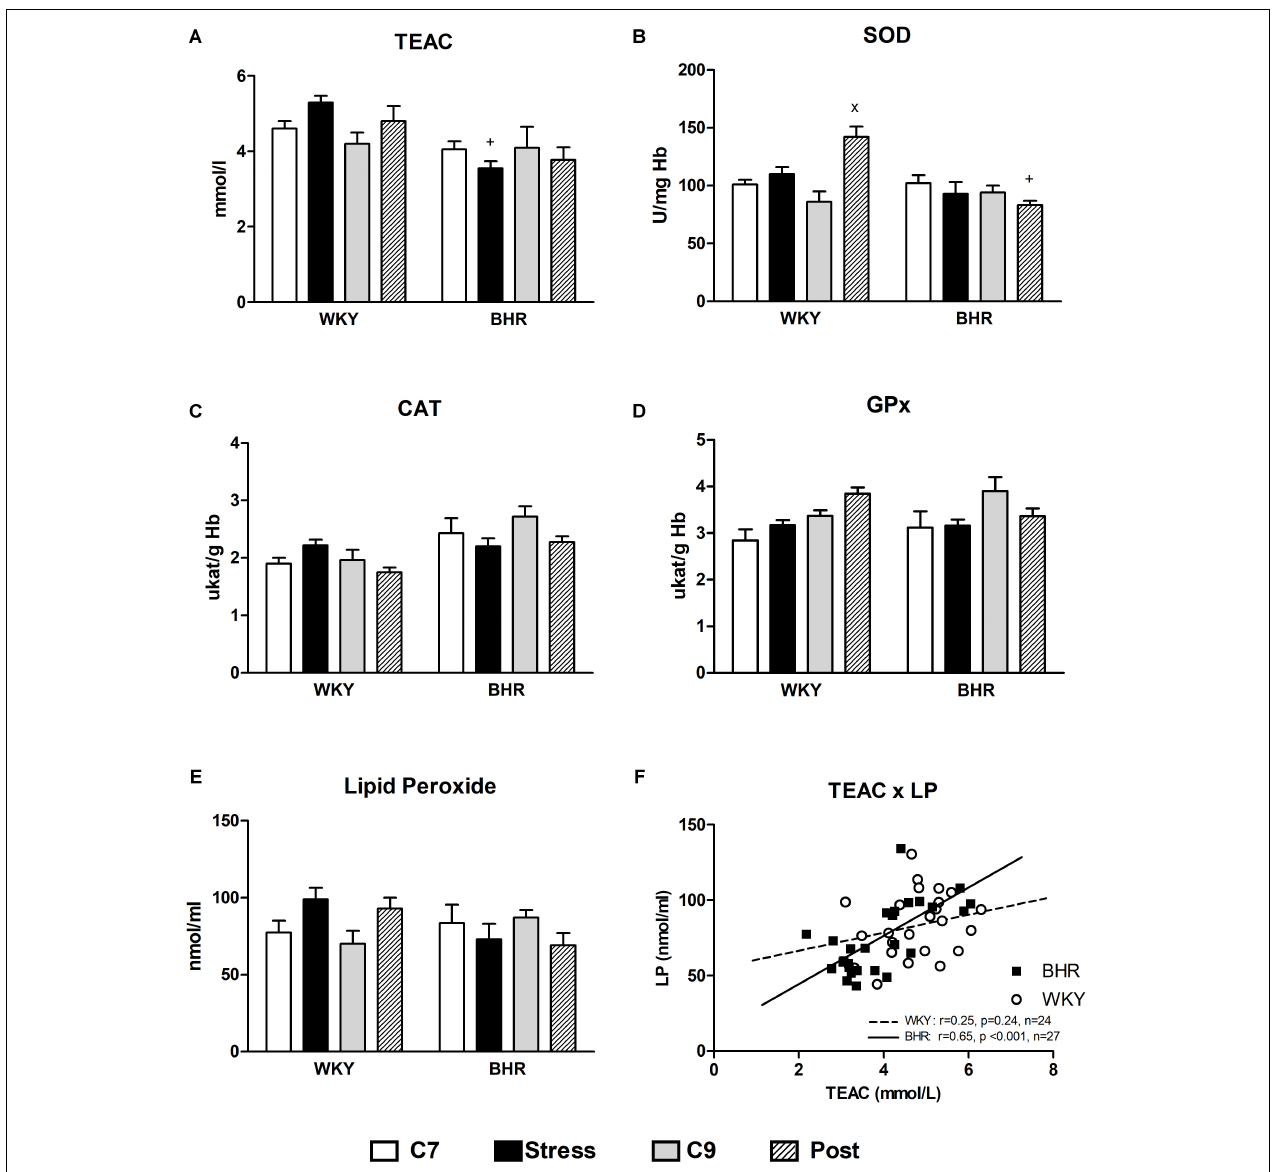
FIGURE 3 | Parameters of oxidative status (A–E) in the blood of normotensive Wistar-Kyoto (WKY) and borderline hypertensive (BHR) rats in 7-week controls (C7, white bar), stress (black bar), 9-week controls (C9, gray bar) and post-stress (Post, strip bar). (F) Shows correlations between TEAC and LP in WKY and BHR rats. CAT, catalase; GPx, glutathione peroxidase; Hb, hemoglobin; LP, lipid peroxides; SOD, Cu/Zn- superoxide dismutase; TEAC, trolox equivalent antioxidant capacity of plasma. The results are mean ± SEM, n = 6–7/group. Symbols: x p < 0.05 vs. nine-week controls (C9) of the same phenotype, + p < 0.05 vs. the same WKY